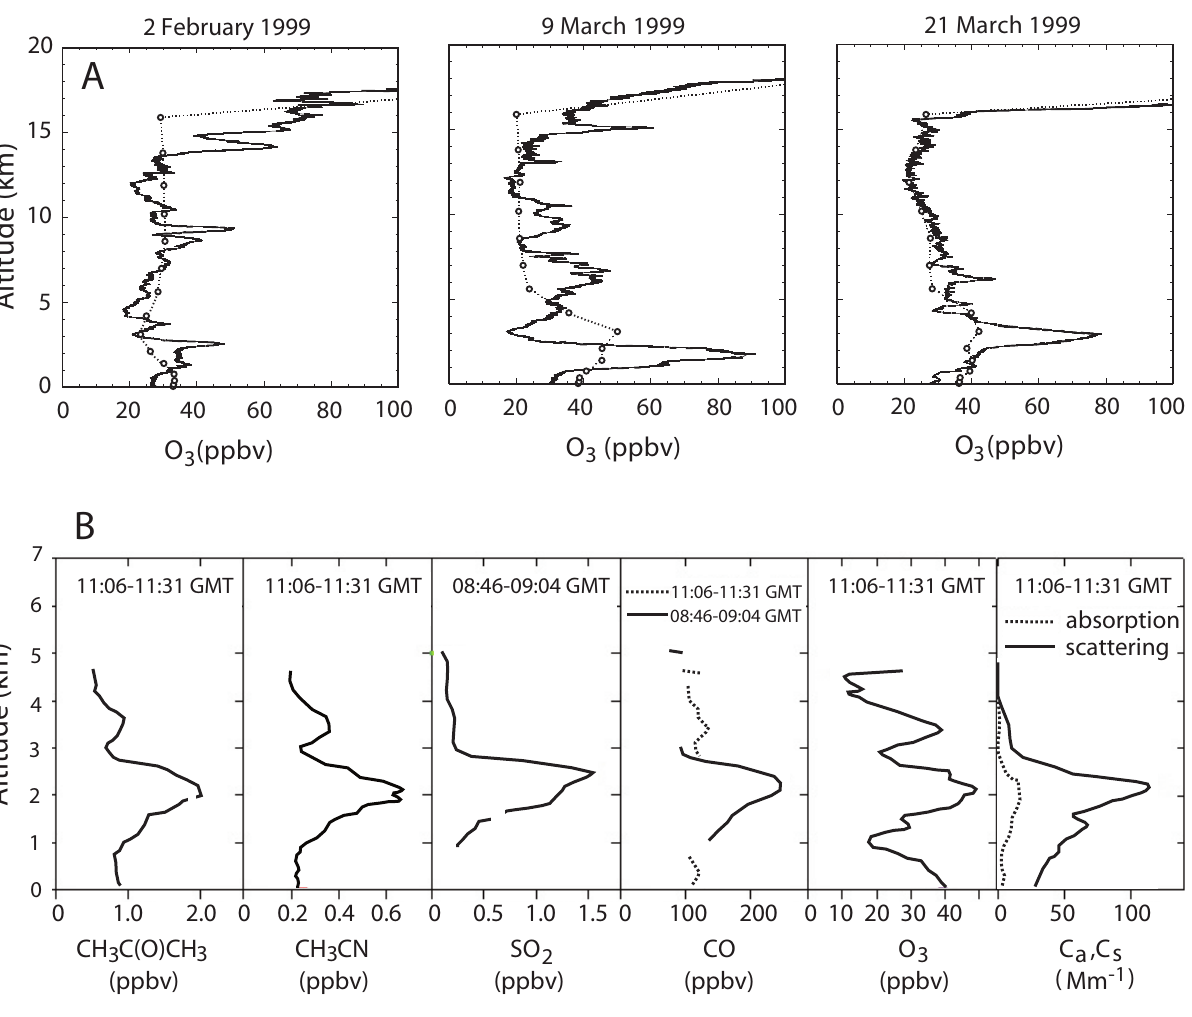
Fig. 19. Examples of the elevated layers observed for ozone and various other trace gases and aerosol properties during INDOEX: (A) O 3 profiles over the Kaashidhoo Climate Observatory (KCO) from balloon sondes (solid line) and computed with the ECHAM model (dashed lines); (B) measurements of several trace gases and the aerosol absorption and scattering coefficients (C a and C s , respectively) at 7.5 ◦ N, 72 ◦ E, made on a flight of the NCAR C-130 aircraft on 13 March 1999 (note that this figure and several of the following figures taken from the published literature use the unit “ppbv” (parts per billion volume) for trace gas mixing ratios, which is equivalent to the SI unit nmol/mol used throughout the text; from Lelieveld et al., 2001, copyright 2001 by the American Academy for the Advancement of Science, reproduced with